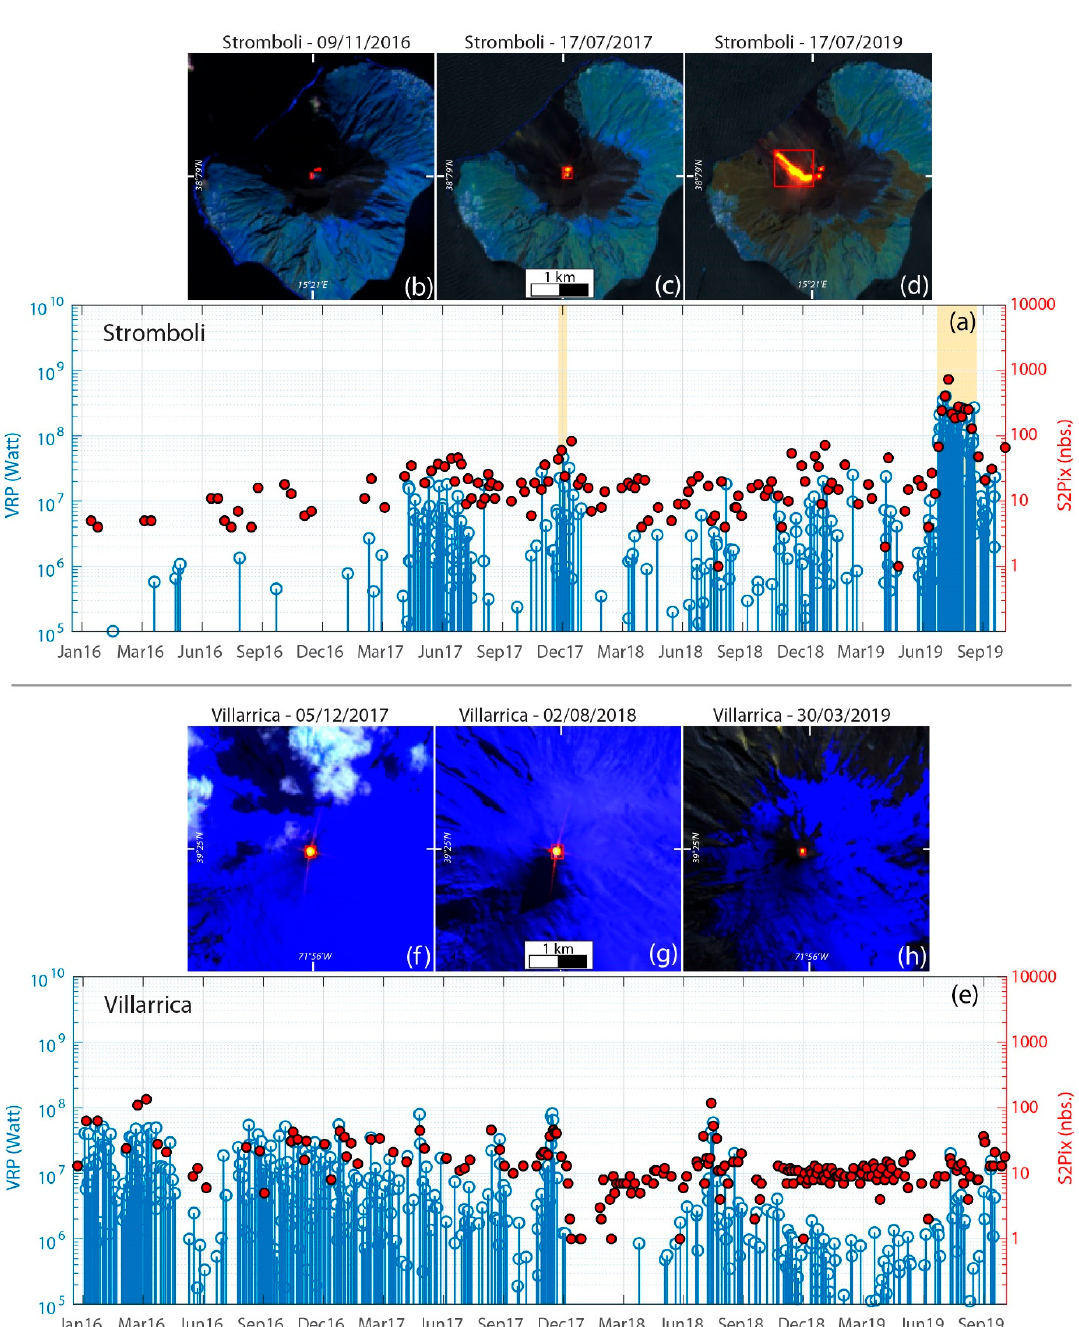
Figure 10. S2Pix and VRP–MIROVA thermal comparison on Stromboli and Villarrica open-vent-type case studies. In ( a , e ) y-logarithmic timeseries. With blue stem on left y-axis, MIROVA VRP heat flux in Watt; with red dots on right y-axis the S2Pix. With yellow fields, major effusive and overflows phases are indicated for Stromboli case. In ( b – d ), particulars of thermal emissions and strombolian to lava flow activity over Stromboli. In ( f – h ), particulars of thermal emissions and open-vent activity of Villarrica.